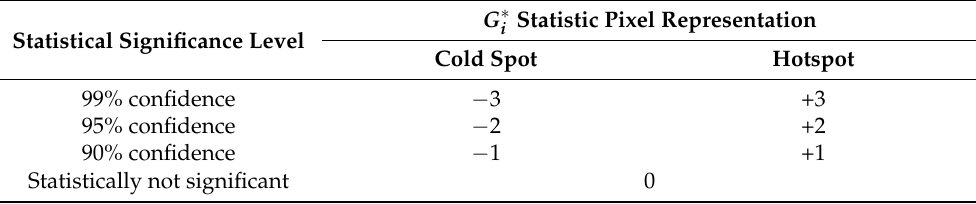
Statistical Significance